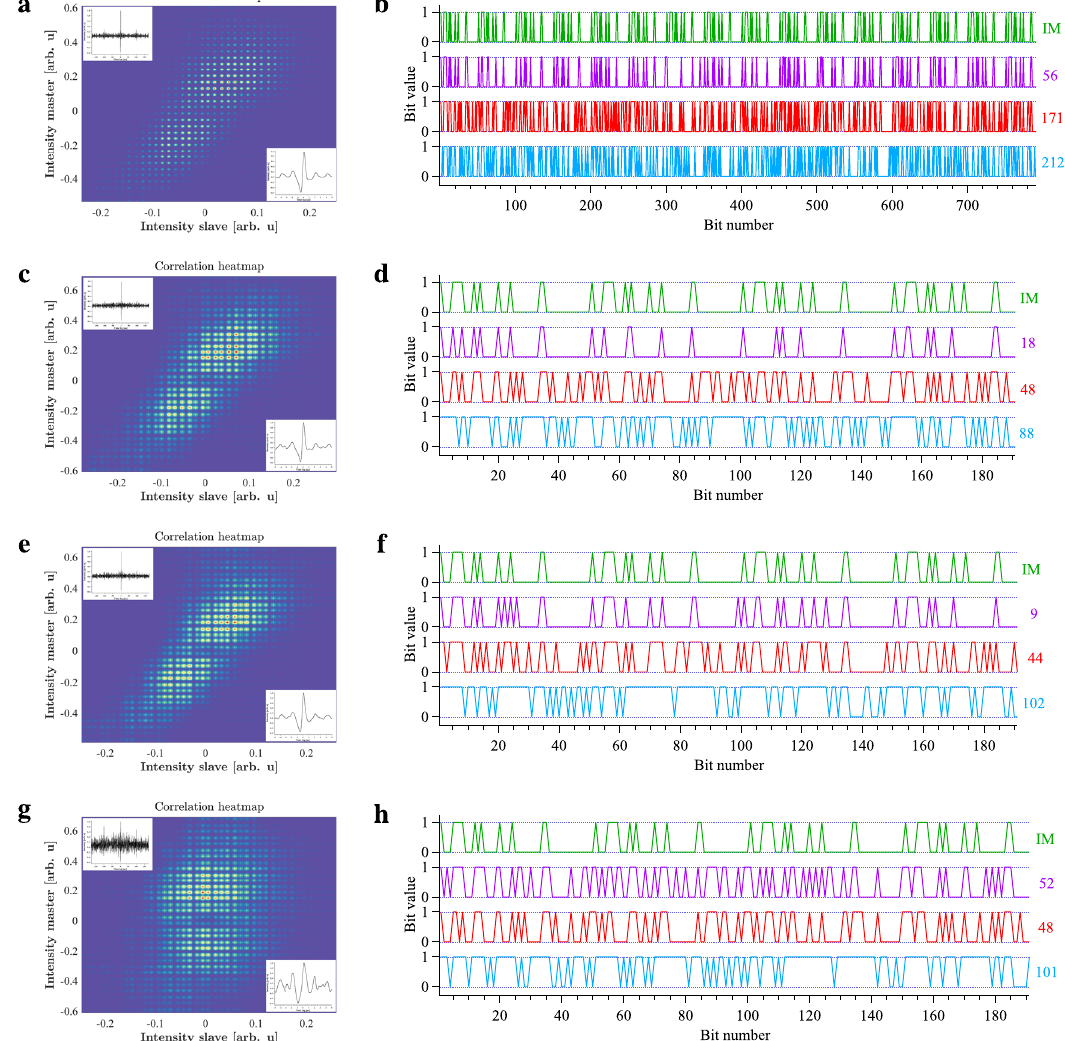
Fig. 2 Private communication with chaos synchronization. 2D and 1D (insets) correlation diagrams for the fi ltered intensity of the slave and the master QCL (left panels). Bit series (right panels) for the initial message (IM in green), the difference (in purple), the master ’ s signal (in red) and the slave ’ s signal (in blue). Except for the initial message, the number of errors is written on the right side of the bit series, with the corresponding color. a , b correspond to the global sequence with 791 bits, c , d correspond to a portion of the global sequence, between 1 and 191, e , f correspond to a portion of the global sequence, between 400 and 591, g , h correspond to a cross-analysis between the slave signal of the second row and the master signal of the